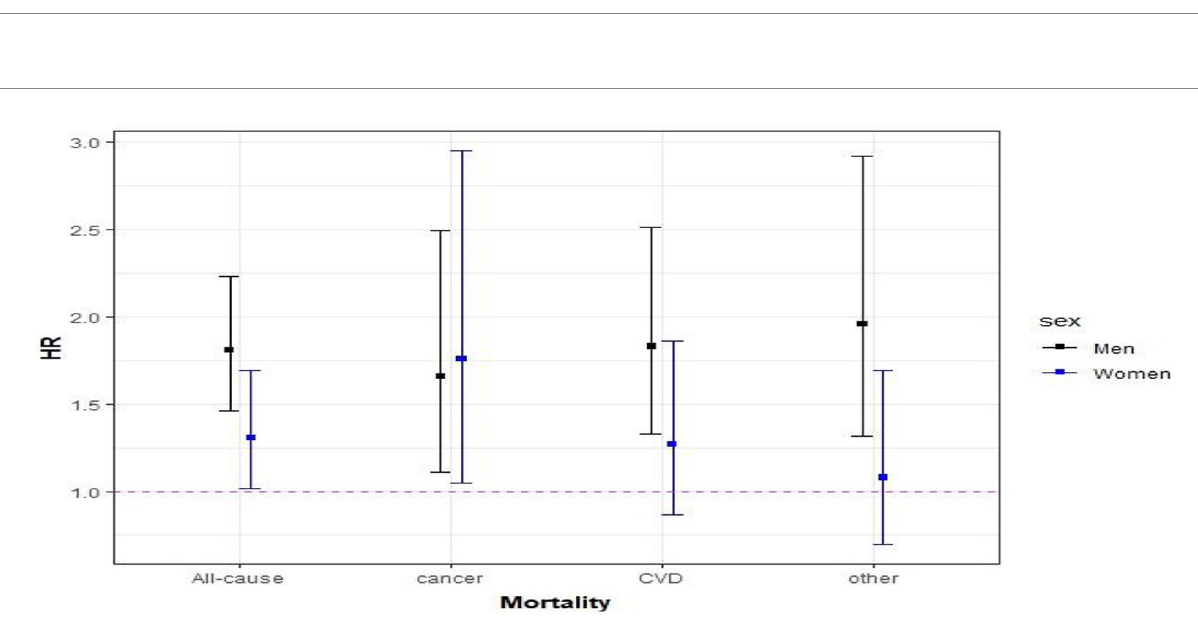
FIGURE 5 Association between multimorbidity and cause-specific mortality. Hazard ratios (95% CIs) of MM were calculated for all-cause and cause-specific mortality and adjusted for education, family status, smoking habit, alcohol use, BMI, and physical